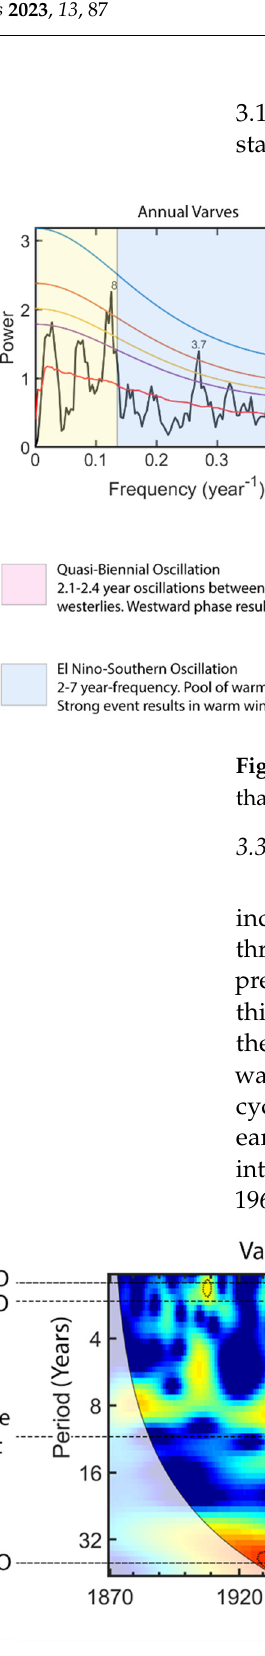
Figure 11. Continuous wavelet transform analysis of varves, light and dark seasonal lamination. Average length of the QBO, ENSO, SSC, and PDO are overlain to demonstrate their probable forcing of the observed cycles in the varve